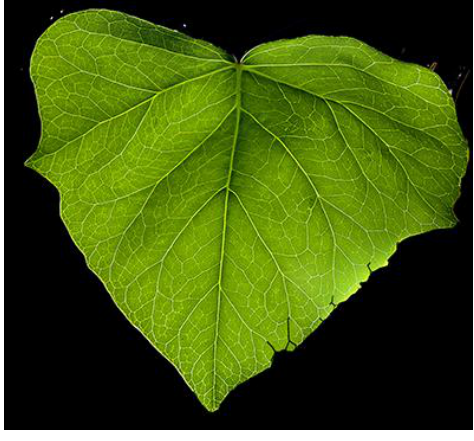
Figure 5. Dynamic range